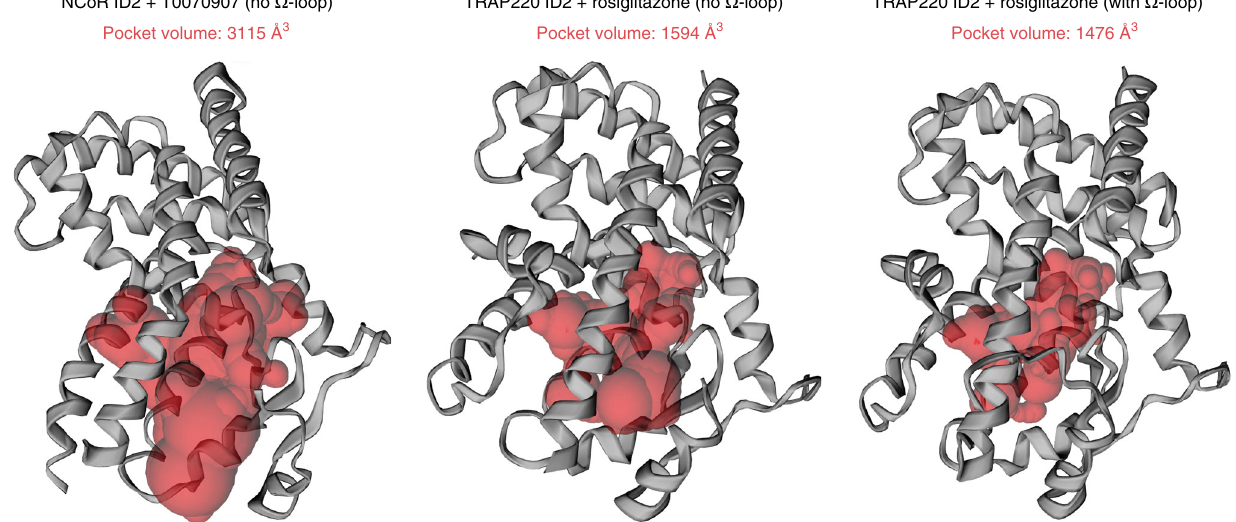
Fig. 4 Ligand-binding pocket volume doubles in the repressive conformation. Ligand-binding pocket volumes (red surfaces) were calculated and displayed using the program CASTp. Ligands were removed from the structures for all calculations. Helix 12 was removed from the repressive conformation structure (PDB 6ONI) to assess the relative pocket volume to the active conformation structures. Calculations for the active conformation structure (PDB 6ONJ), which displays density for the Ω -loop region, were performed with and without the Ω -loop region for comparison to the repressive conformation structure, which lacks the Ω -loop